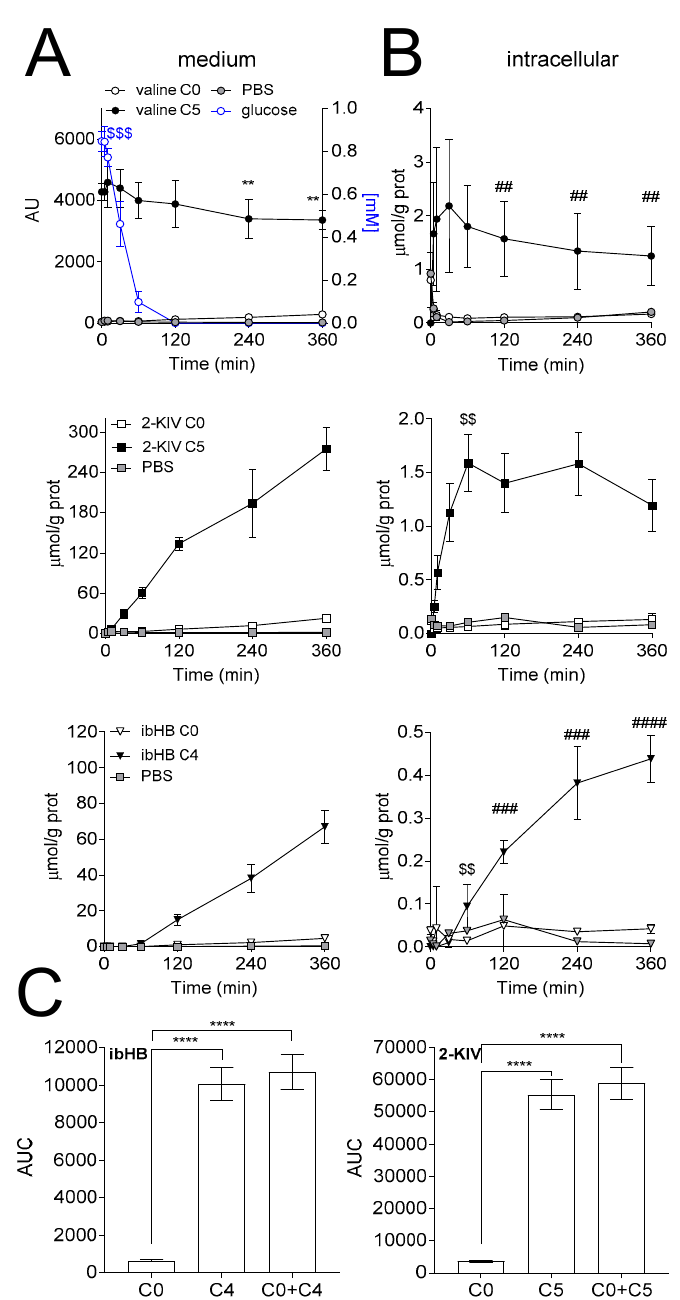
Figure 2. Isotopomer analysis in hepatocytes. Extracellular ( A ) and intracellular ( B ) time courses of valine, 2-KIV and ibHB concentrations in the HepG2 experiment. ( C ) AUC of the secreted ibHB and 2-KIV. Glucose concentration was measured in the medium and is depicted in blue (A). ( n = 3). ** p < 0.01, as compared to 5 min; ## p < 0.01, ### p < 0.001, and #### p < 0.0001, as compared to 60 min; $$ p < 0.01 and $$$ p < 0.001, as compared to 30 min paired t-test. (C) **** p < 0.0001, one-way ANOVA with Tukey’s post-test for multiple comparisons. AU: arbitrary unit.